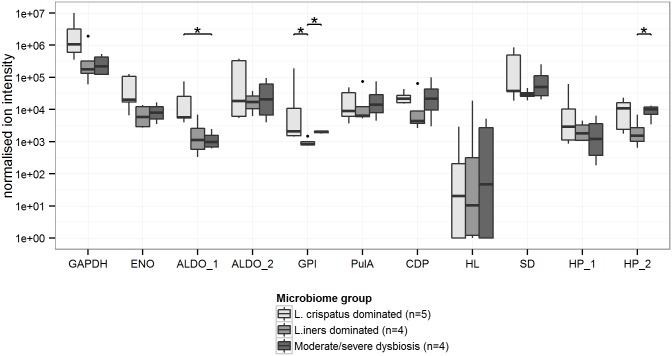
Relative abundances of L. crispatus proteins in cervicovaginal lavages of women with positive L. crispatus 16S rDNA microarray results (n = 13) among three cervicovaginal microbiota groups.Homologous proteins from different strains are numbered (Table 1). Box plots represent median (black line), first and third quartiles (box) and range within 1.5 times the interquartile range from the box (whiskers). Outliers are plotted as points. *p-value<0.05. Abbreviations: GAPDH: glyceraldehyde-3-phosphate dehydrogenase; ENO: enolase; ALDO: fructose-bisphosphate aldolase; GPI: glucose-6-phosphate isomerase; PulA: pullulanase type I; CDP: cell division protein; HL: hydrolase; SD: YSIRK signal domain/LPXTG anchor domain surface protein; HP: hypothetical protein.